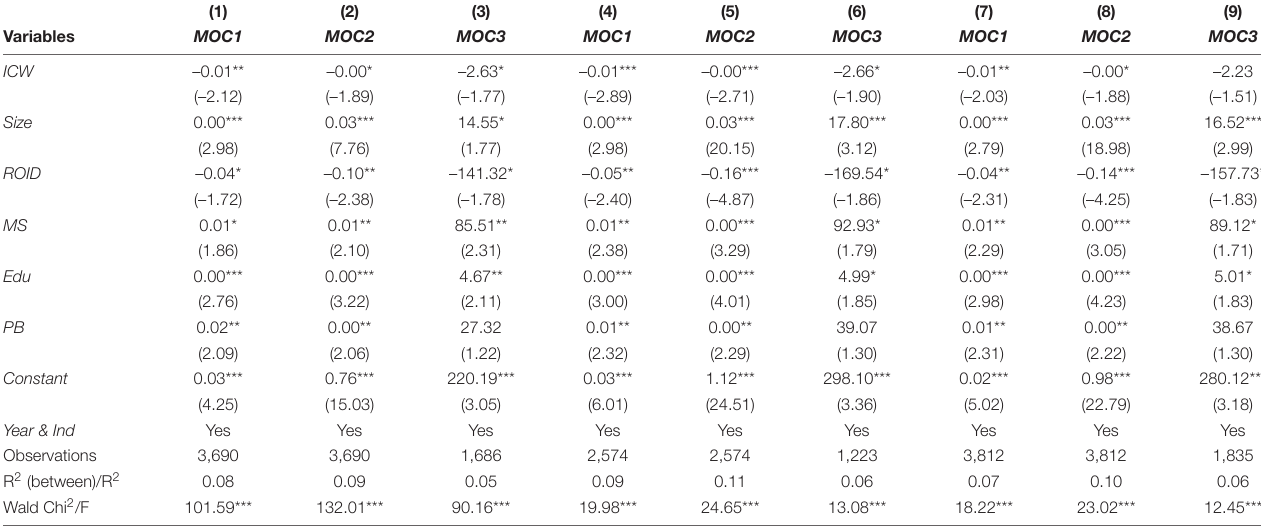
TABLE 4 | Robustness test